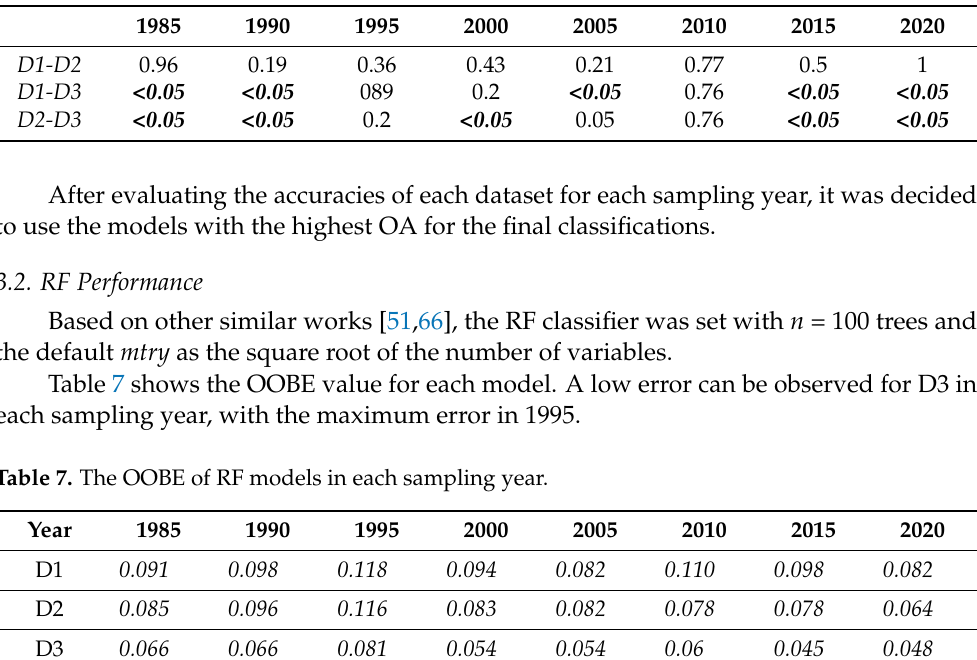
Table 6. McNemar test (only p -value) on differences in accuracy between pairs of classifiers based on the different datasets for each year. The values in bold indicate statistically significant differences with p < 0.05.